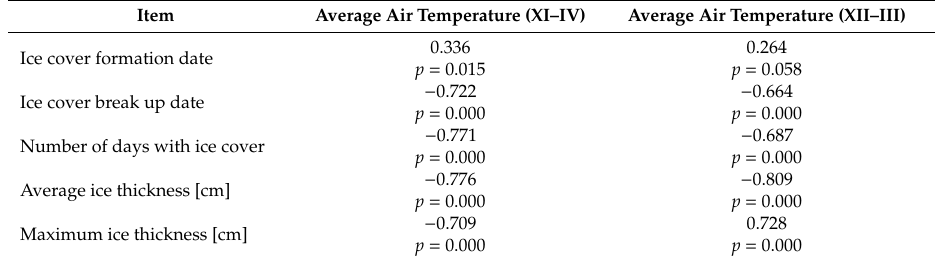
Table 2. Pearson’s correlation coe ffi cients between water body ice cover data and meteorological data for the Kozłowa G ó ra water body.